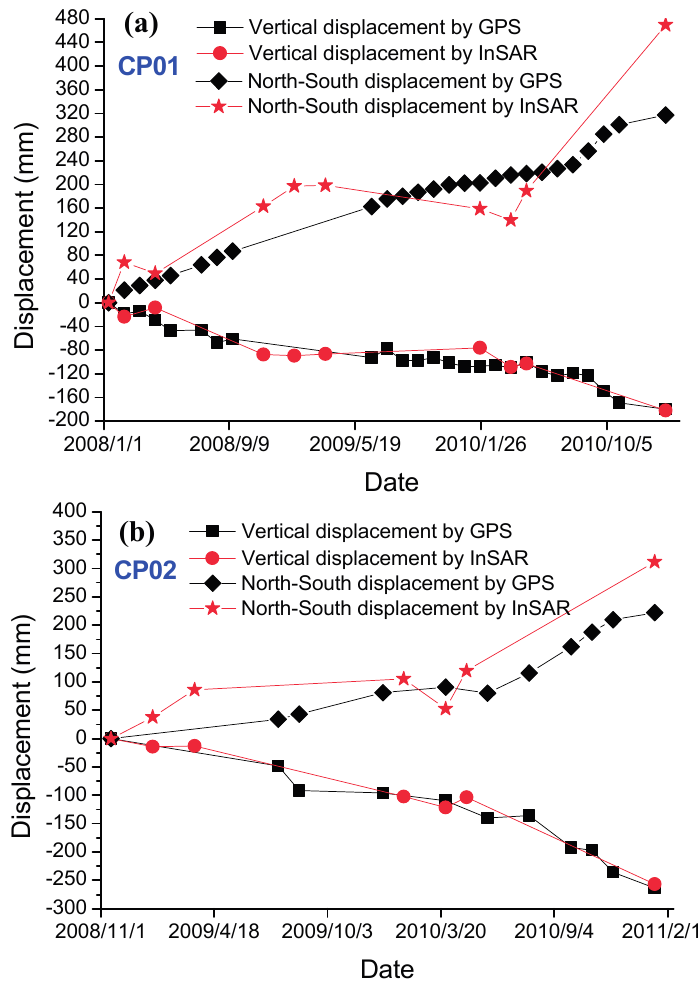
Figure 10. ( a ) Displacement time series along vertical and north–south directions obtained by GPS and synthetic aperture radar interferometry (InSAR) of CP01. ( b ) Displacement time series along vertical and north–south directions obtained by GPS and InSAR of